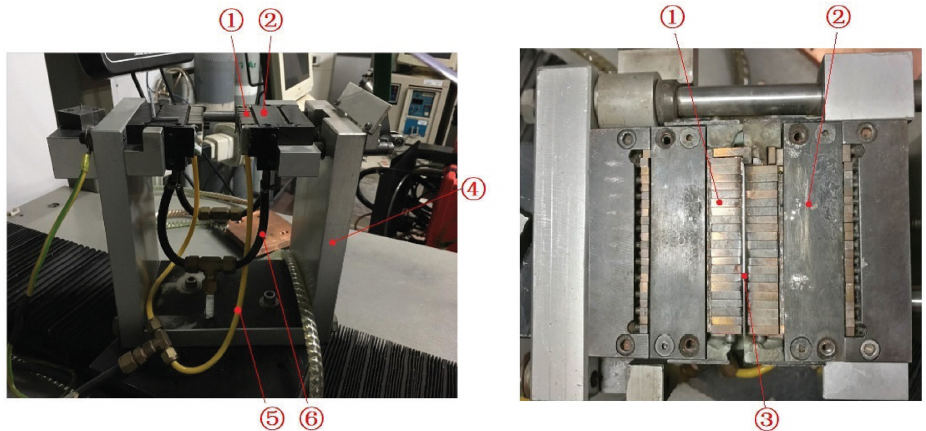
Figure 6. The structure of MPAW fixture. (cid:192) Copper bonds. (cid:193) Clamping structure. (cid:194) Inconel 718 test piece. (cid:195) Aluminum frame. (cid:196) Shield gas channel. (cid:197) Cooling water